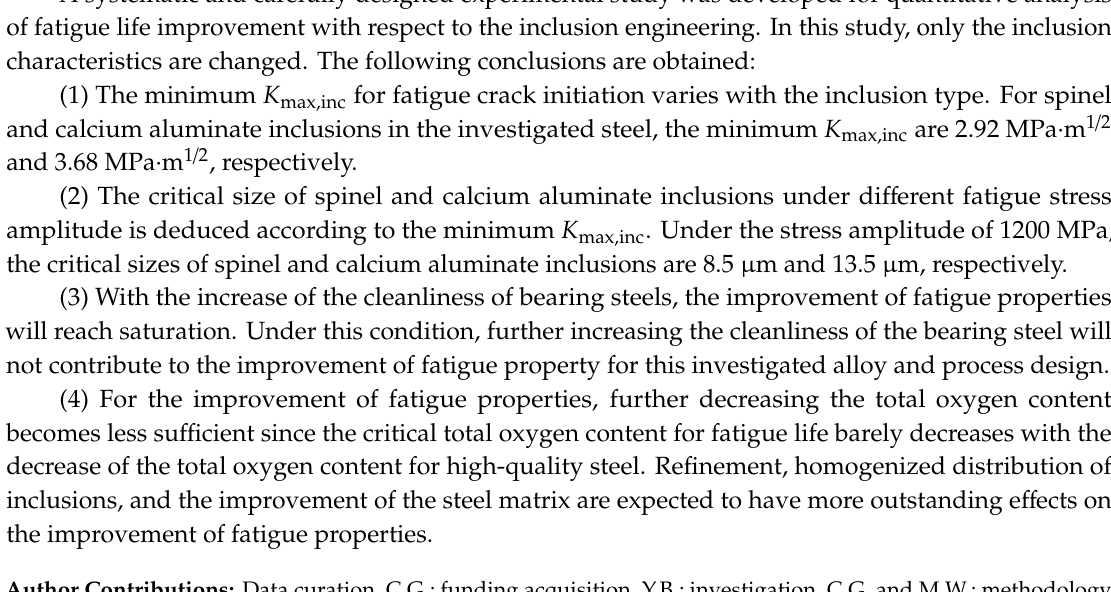
Figure 14. The e ff ects of critical T.O and non-critical T.O on the variation of Figure 14. The effects of critical T.O and non-critical T.O on the variation of T.O.